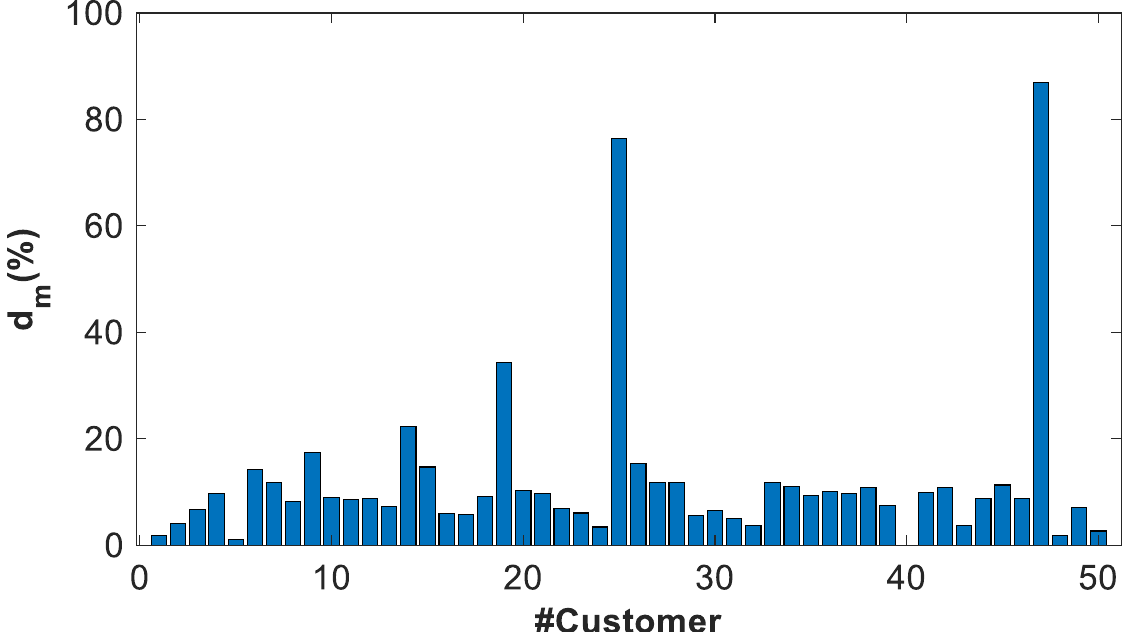
Figure 19. The partial deviation of the full power profiles, 𝑌 𝑚 ̂ , with the respect to the estimate power profile 𝑌̂ , obtained using the reference algorithm without the clustering phase. The deviation is normalized by the upper bound of the contractual power of the subset of considered power profiles (i.e., P = 16.5 kW).